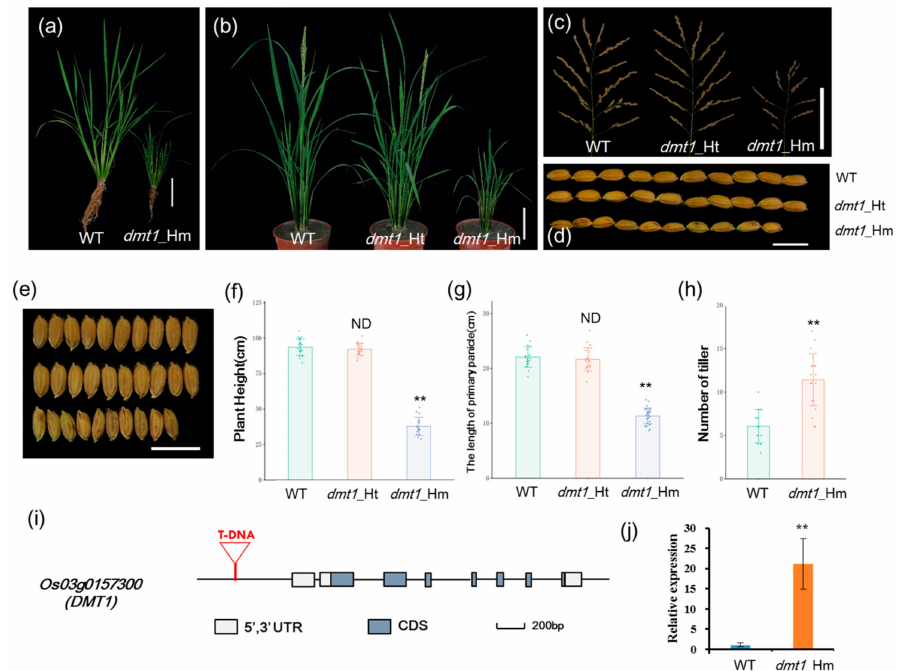
Figure 1. Characterization of the rice dwarf and multi-tillering1 (dmt1) mutant plants. ( a ) dmt1 homozygous mutant exhibited a dwarf phenotype in the tillering stage. Scale bar: 10 cm. ( b ) dmt1 homozygous mutants exhibited dwarf and multi-tillering phenotypes compared with those of the wild type (WT) and heterozygous mutants during the reproductive stage. Scale bar: 10 cm. ( c ) The phenotype of panicle branching in the WT (left), dmt1 heterozygous mutant (middle), and dmt1 homozygous mutant (right). Scale bar: 10 cm. ( d , e ) Seed length and width in the WT (upper), dmt1 heterozygous mutant (middle), and dmt1 homozygous mutant (bottom). Scale bar: 1 cm. ( f , g ) Statistical analysis of plant height ( f ) and primary panicle length ( g ) in the WT, dmt1 heterozygous mutant, and dmt1 homozygous mutant. Values represented by means ± SE. ∗∗ p < 0.01, Student’s t -test, n = 30; ( h ) Statistical analysis of the number of tillers in the WT and dmt1 homozygous mutant. Values are expressed is represented by means ± SE. ∗∗ p < 0.01, Student’s t -test; n = 30. ( i ) Schematic diagram of DMT1 . DMT1 consisted of eight exons and seven introns. T-DNA inserted into the promoter region. Boxes and lines represent exons and introns, respectively. ( j ) DMT1 transcripts were detected in the dmt1 mutant and the WT using qRT-PCR. ACTIN1 was used for a control. ** p < 0.01, Student’s t -test. Hygromycin resistance test showed that the dmt1 cosegregate with the resistance maker in the T 3 population. Of 517 T 3 individuals, the progeny of plants exhibited phenotypic segregation of normal height to dwarf of ~3:1 (389:128), indicating that the mutant phenotype was controlled by a single recessive gene. To isolate the gene disrupted in the dmt1 mutant, Inverse polymerase chain reaction (IPCR) was used to separate the T-DNA flanking region [23]. Sequence analysis revealed that T-DNA was inserted in 1949 bp upstream of the start codon Os03g0157300 (Figure S2), which was predicted to be a plasma membrane protein OsMCA1 (Mid1-complementing activity1) . Os03g0157300 was potentially the gene responsible for the dmt1 mutant phenotype and was designated as DWARF AND MULTI-TILLERING1 (DMT1) . The OsDMT1 gene consisted of eight exons and seven introns (Figure 1i). qRT-PCR was performed to examine DMT1 transcript levels in the mutant and WT. The result showed that the expression of DMT1 was significantly higher (~21 fold) in the dmt1 mutant than in the WT (Figure